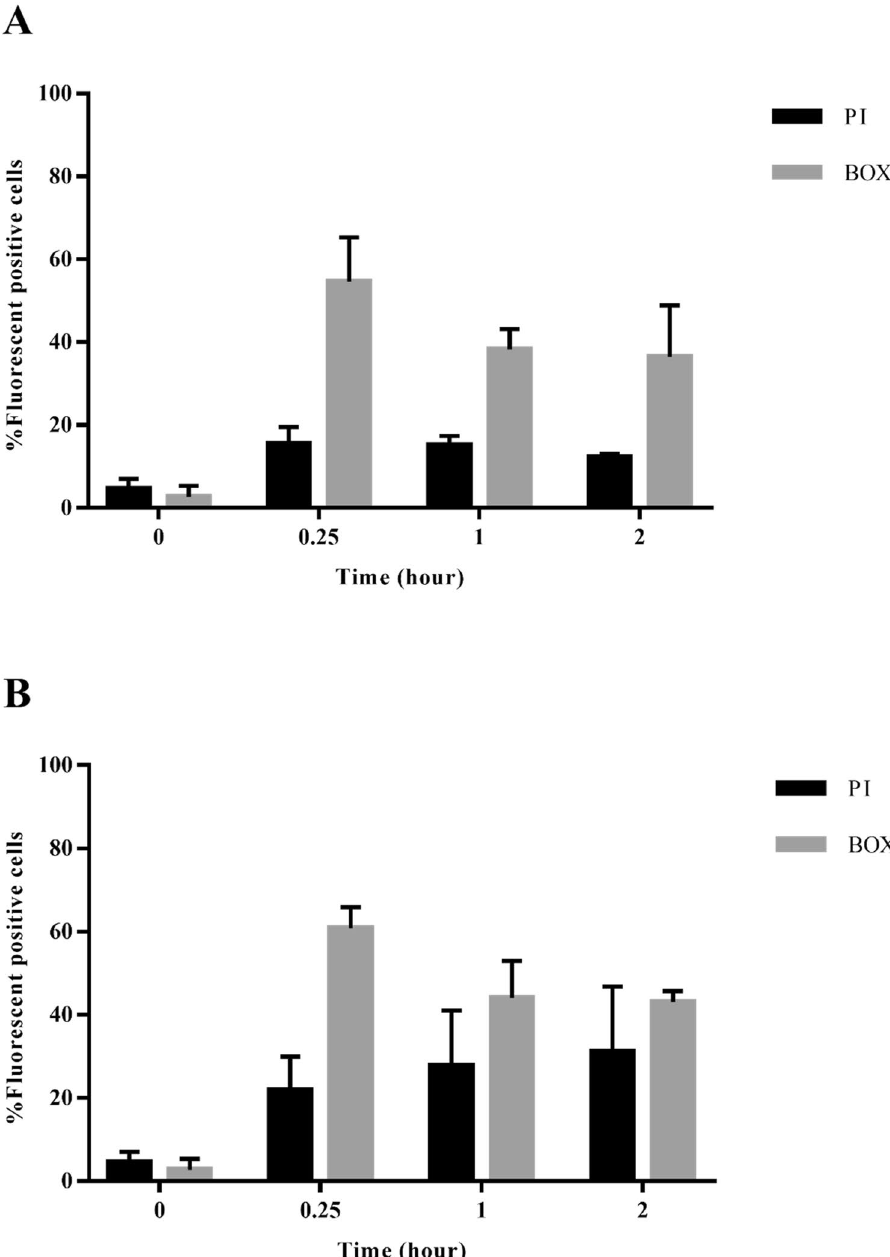
Figure 5. Percentage of fluorescent positive cells stained with PI or BOX after treatment with D-AP19 for 2 h. A. baumannii ATCC 19,606 was treated with half MIC ( A ) or 1 × MIC ( B ), and stained with a fluorescent